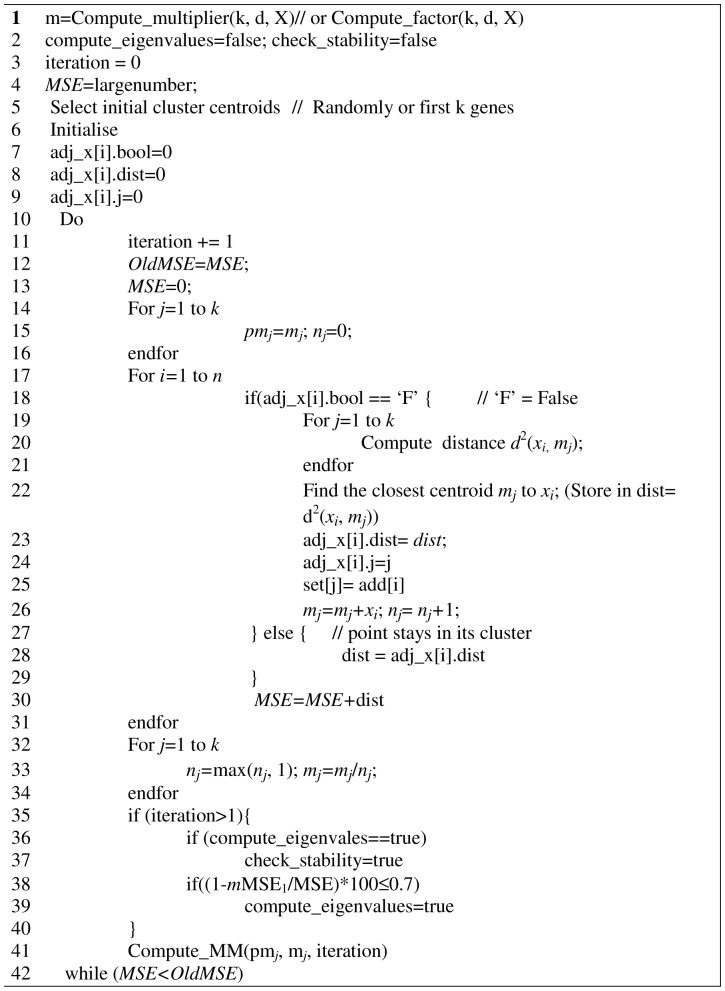
Pseudocode of our main program for MMk-means.It runs similar to the traditional k-means except that it is equipped with a metric matrices based mechanism to determine when a cluster is stable (that is, its members will not move from this cluster in subsequent iteration). This mechanism is implemented in sub-procedure Compute_MM of
Figure 1. We use the theory developed by Zha et al.
[20] from the singular values of the matrix X of the input data points to determine when it is appropriate to execute Compute_MM during the k-means iterations. This is implemented in lines 34–40.